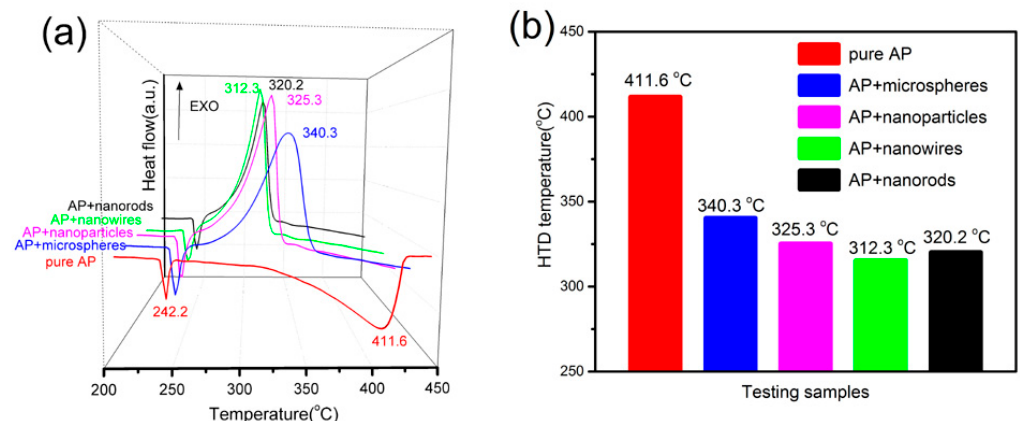
Figure 7. ( a ) Differential scanning calorimeter (DSC) curves of ammonium perchlorate (AP) mixed with as-prepared NiCo 2 O 4 nanostructures and pure AP at a heating rate of 10 K/min; ( b ) histogram of the corresponding high-temperature decomposition (HTD) temperatures.